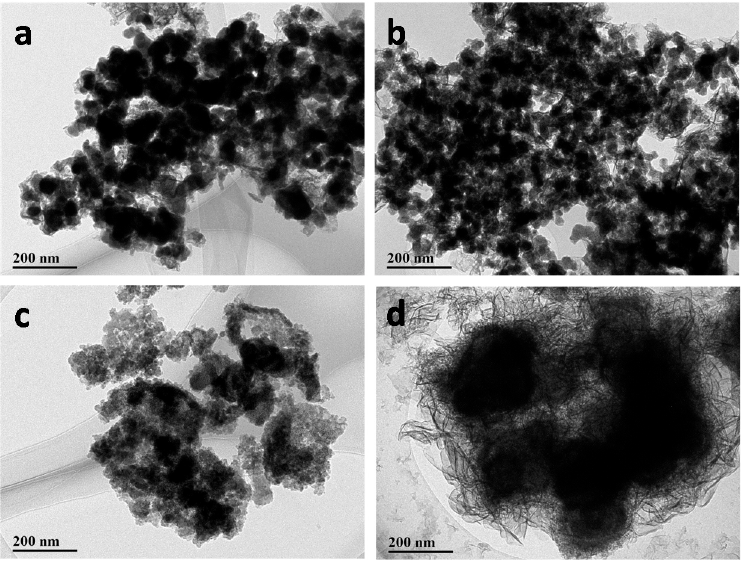
Figure 2. TEM (transmission electron microscopy) images of Co–B particles prepared in ( a ) water; ( b ) methanol; ( c ) acetone; and ( d ) acetonitrile.